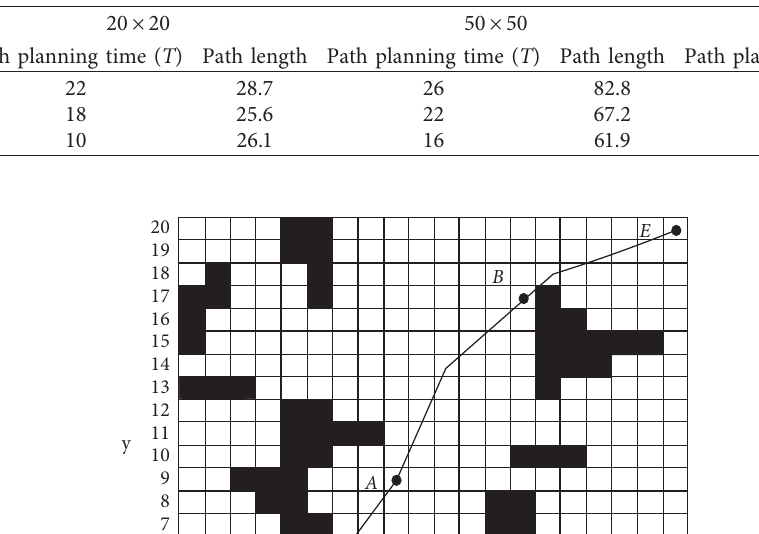
Table 3: Comparison under different environments.